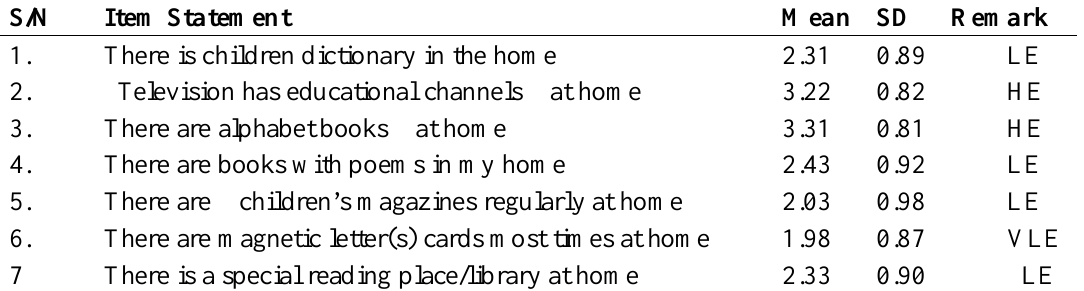
Table 1: Mean analysis of extent of availability of reading resources.